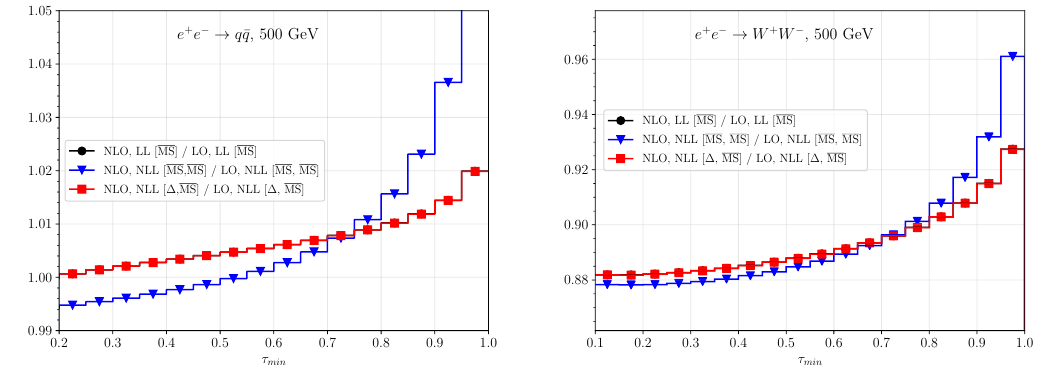
Figure 14 . As in figure 12, with K-factors computed by not including the contribution stemming from eq. (B.3) in the LO cross sections. Left panel: q ¯ q production; right panel: W + W − production.